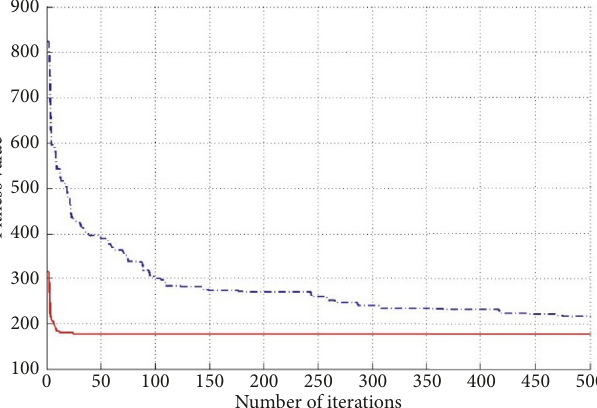
Figure 16: Algorithm convergence charts of GA and GA-TS.